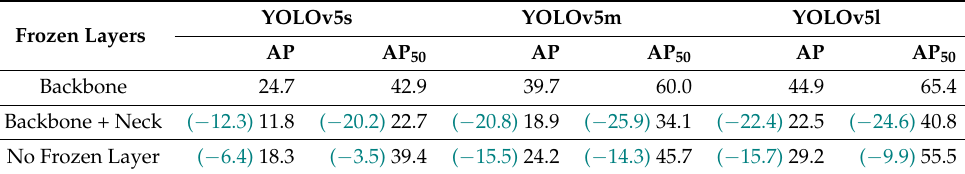
Table 3. Study on fine-tuning pre-trained models. Frozen